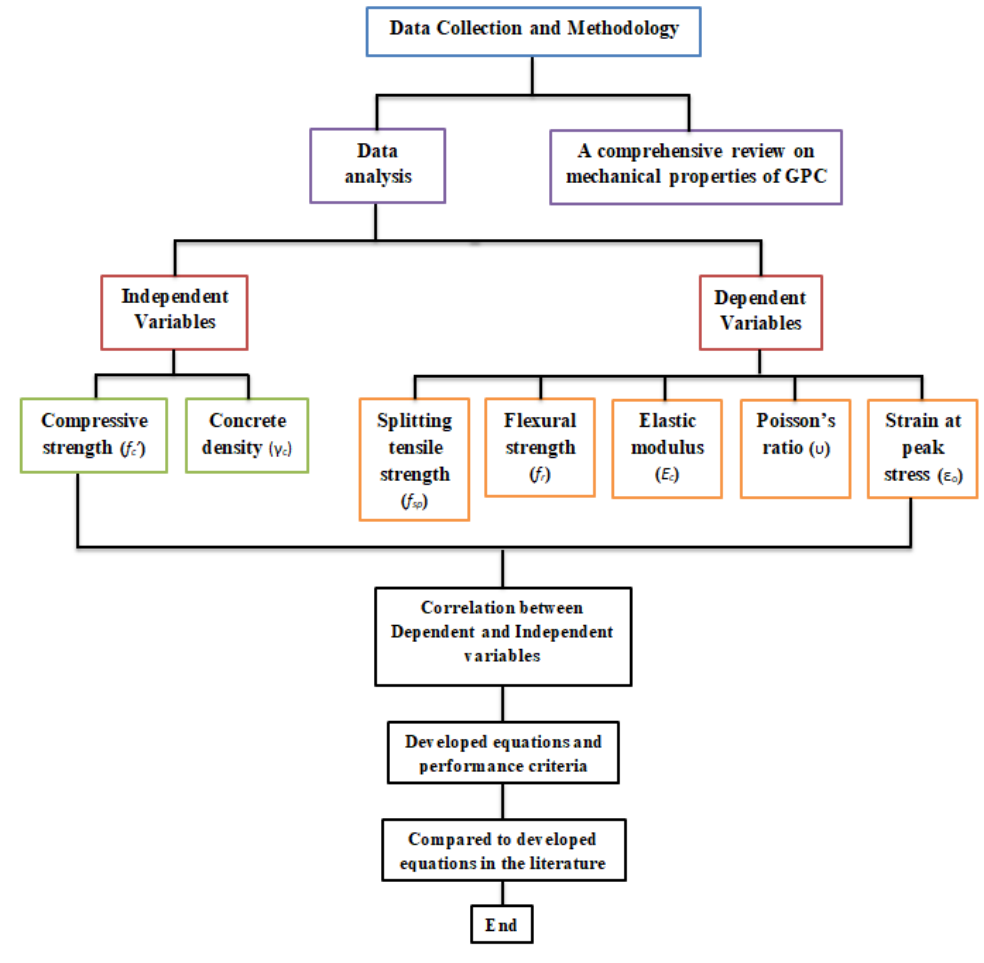
Figure 1. The flow chart diagram process followed in this study.